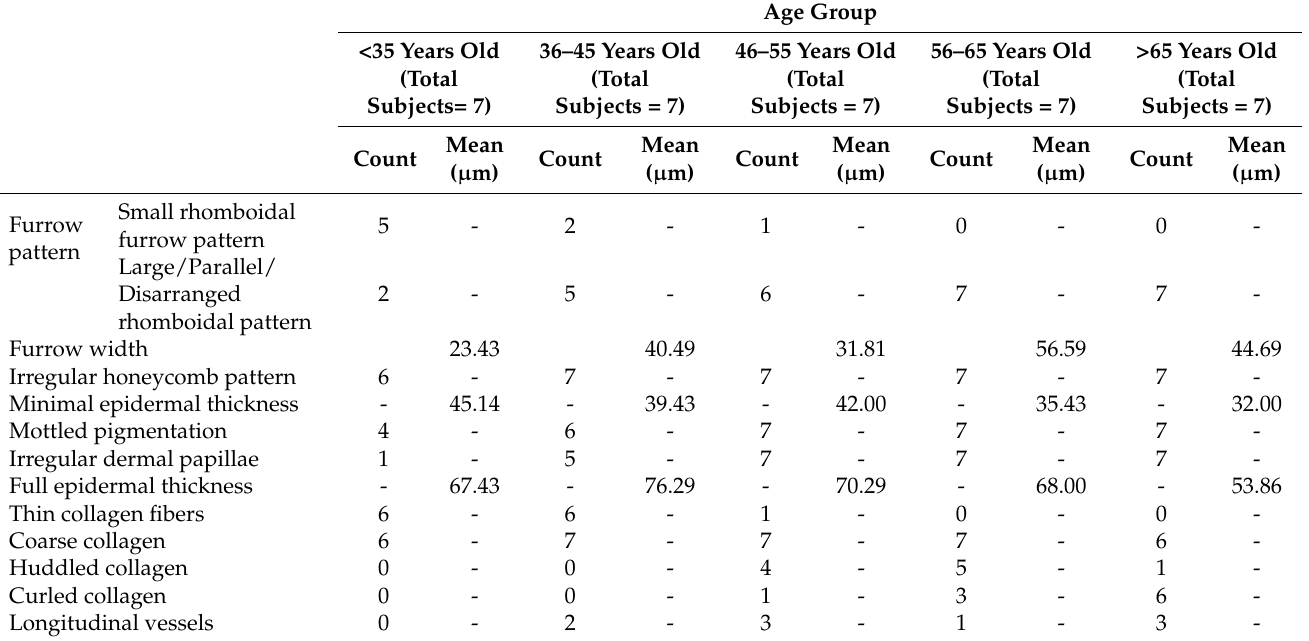
Table 4. Reflectance confocal microscopy parameters related to skin aging.